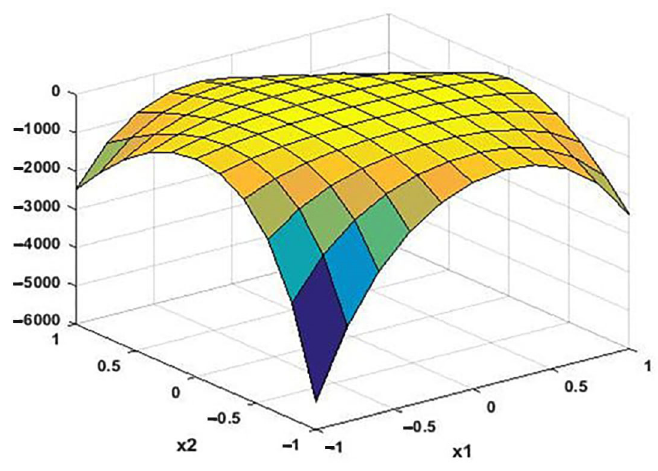
Figure 3. Surface h( 𝑥 ) for a large range of 𝑥 (cid:2869) (𝑡), 𝑥 (cid:2870) (𝑡) and checking the condition h(𝑥) = 𝑥 (cid:3021) (cid:3435)𝑄 (cid:2870) (𝑥) − 𝑄 (cid:2869) (𝑥)(cid:3439)𝑥 ≤ 0 for the stability of a nonlinear system (21).